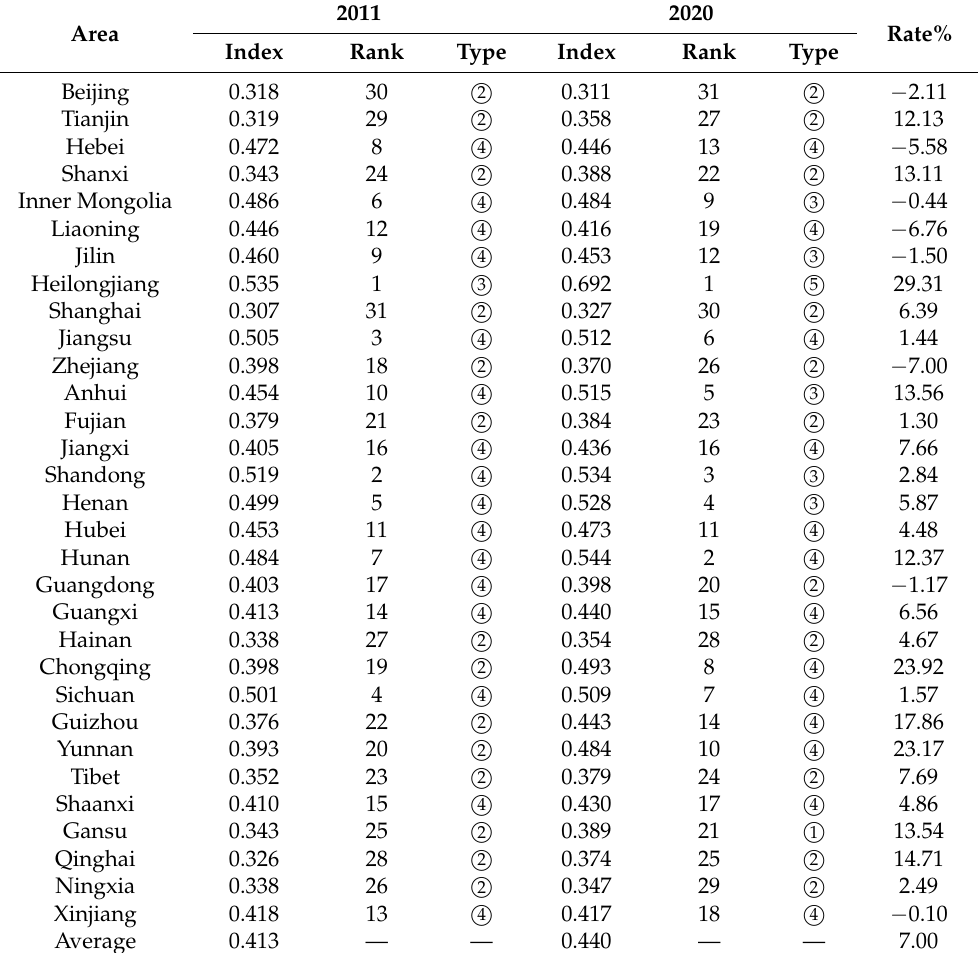
Table 7. The coupling coordination degree and comprehensive evaluation of agricultural eco- efficiency and food security in various provinces of